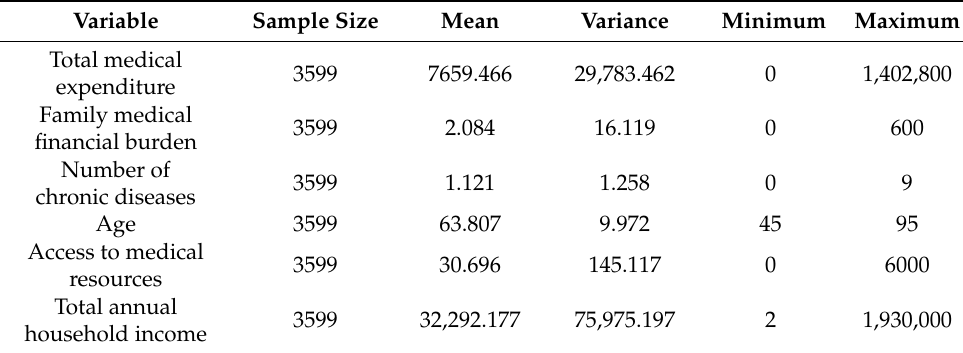
Table 1. Sample descriptive